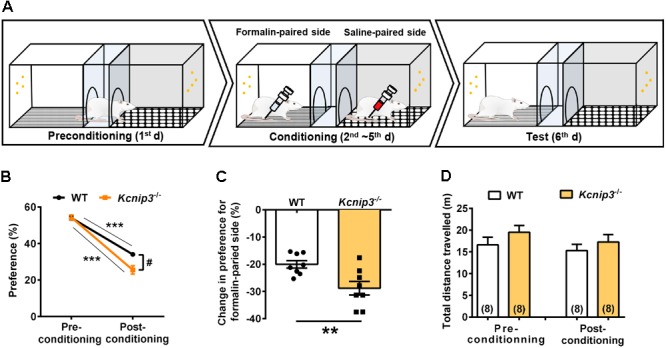
Kcnip3 gene deletion exacerbates the aversive emotional response of pain. (A) Schematic diagram of a three-chamber conditioned place avoidance (CPA) apparatus and training procedure. (B) Percentage of the time spent in the formalin-paired compartment before and after the conditioning procedure in wild-type and Kcnip3-/- rats. n = 8 for both groups. ∗∗∗p < 0.001, comparison between preconditioning and postconditioning; #p < 0.05, comparison between the two curves, two-way repeated-measures ANOVA followed by Sidak’s multiple comparisons test. (C) Change in the percentage of the time spent in the formalin-paired compartment after the conditioning procedure in comparison to that prior to the conditioning procedure in wild-type and Kcnip3-/- rats. n = 8 for both groups. ∗∗p < 0.01, unpaired t-test. (D) Total distance traveled before (left, preconditioning) and after (right, postconditioning) the conditioning procedure in wild-type and Kcnip3-/- rats. n = 8 for both groups. p > 0.05, unpaired t-test.